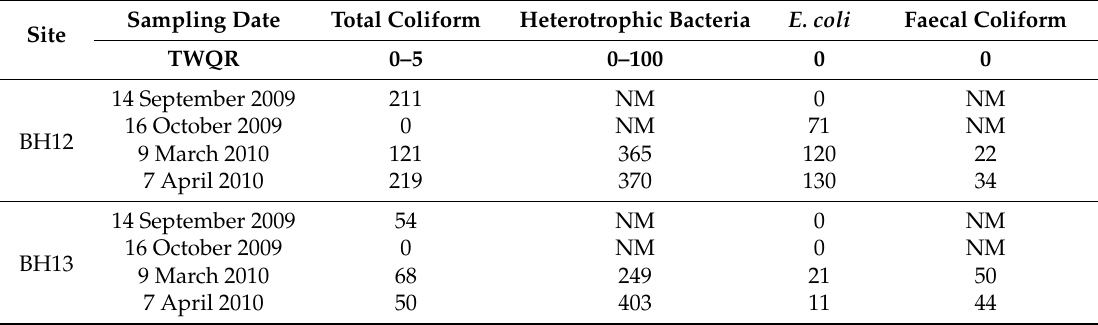
Table 6. Microbial water quality